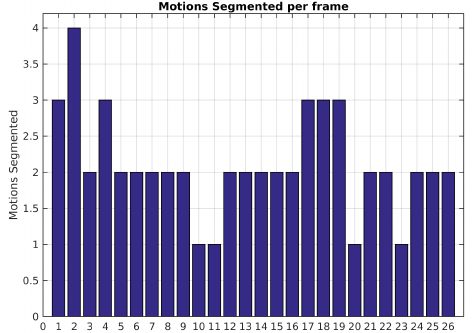
Figure 6. Number of motions by frame with baseline